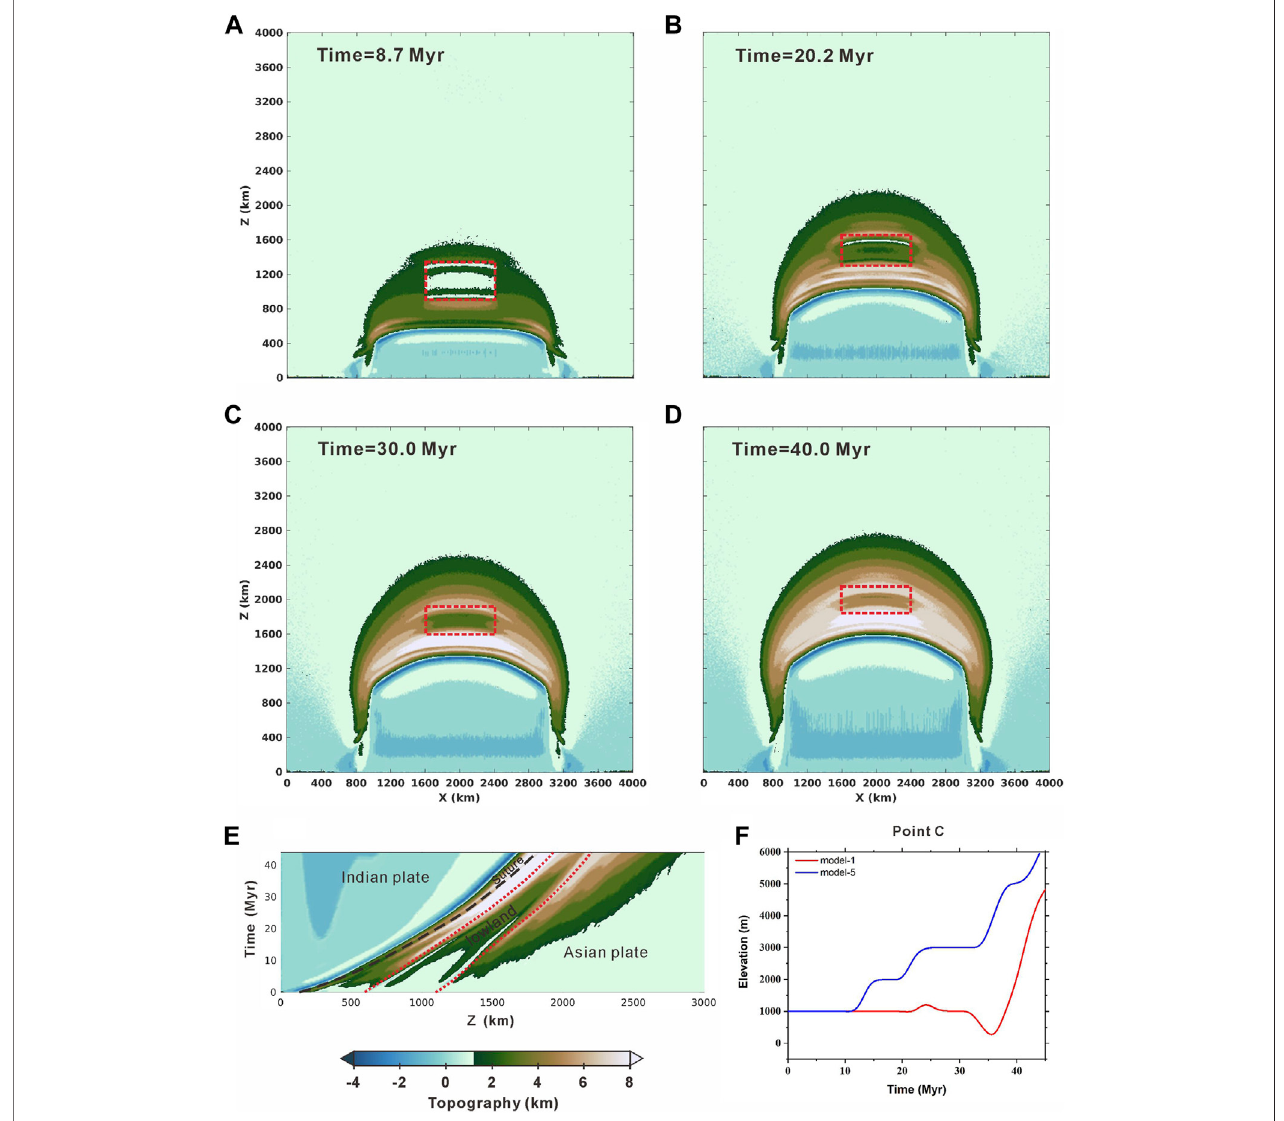
FIGURE9| Topographicevolutionofthemodel-5( Table2 ).Snapshotsshowingthesurfacetopographyat (A) 8.7 Myr (B) 20.2 Myr (C) 30.0 Myr,and (D) 40.0 Myr (E) display the topographic evolution with time along section x = 2,000 km (F) showing the difference of uplift history ofcenter point C between the reference model (red line) and